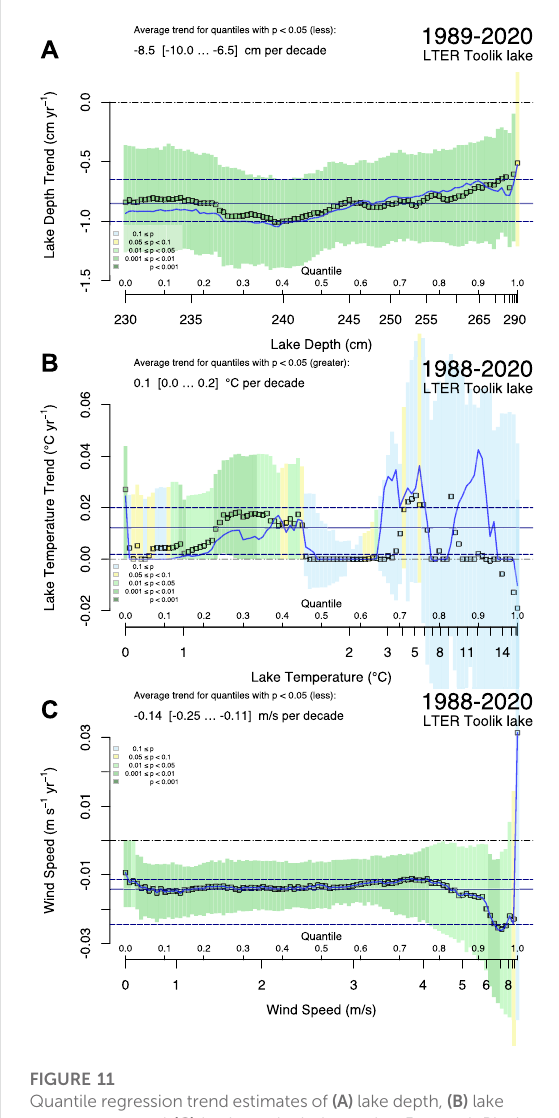
FIGURE12 Quantile regression trend estimates of (A) increasing occurrence of hours with rainfall, (B) as in (A) but restricted to the growing season months May – September, and (C) rainfall amount. Display as in Figure 11, with the addition of red dashed lines indicating equal percentage of